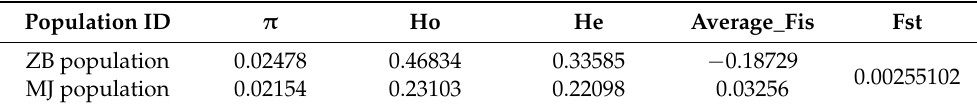
Table 3. Comparison of population genetic parameters in the ZB population and MJ population. Population